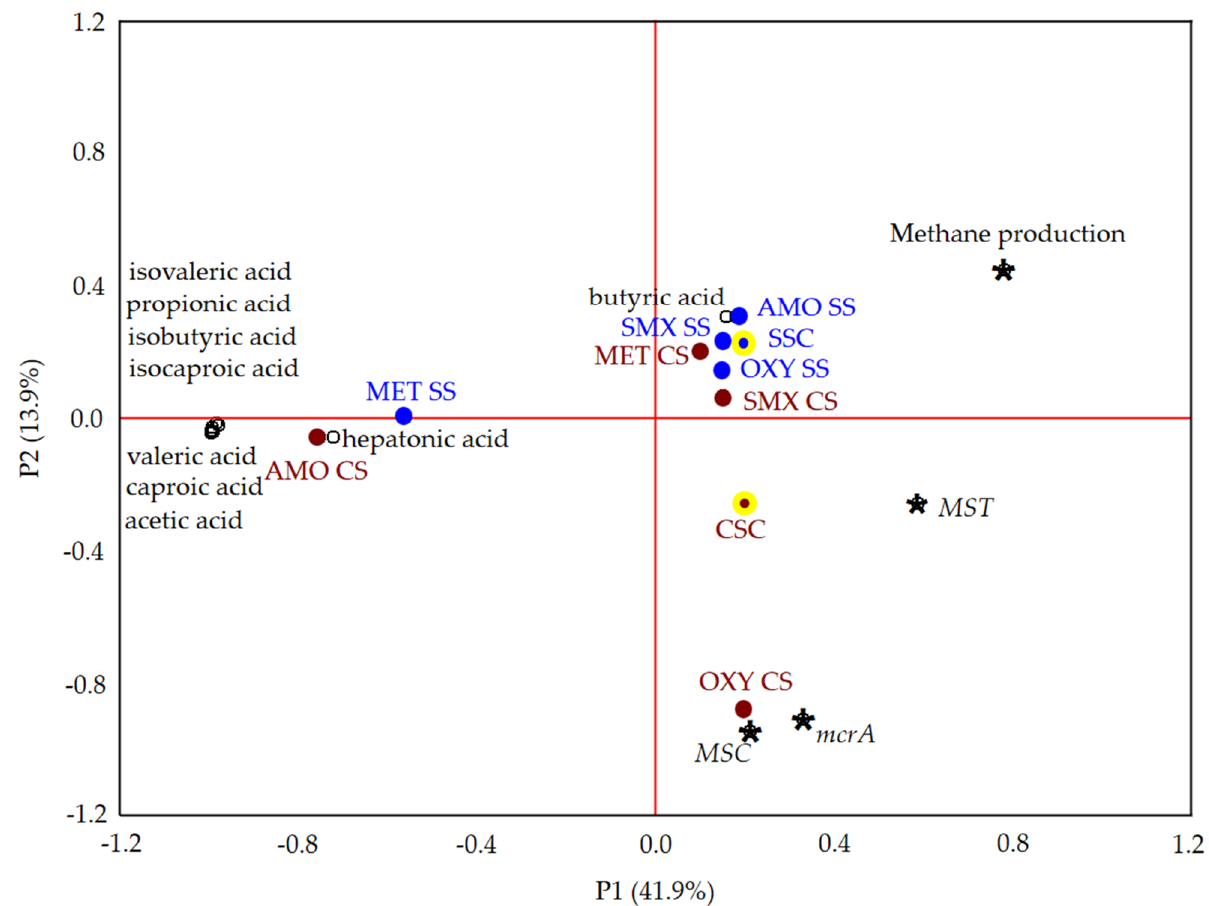
Figure 3. Principal component analysis (PCA) based on the distribution of the analyzed genes characteristic of methanogens and parameters of methane fermentation in bioreactors with sewage sludge (SS) and cattle slurry (CS). (SSC) control samples of sewage sludge, (CSC) control samples of cattle slurry.